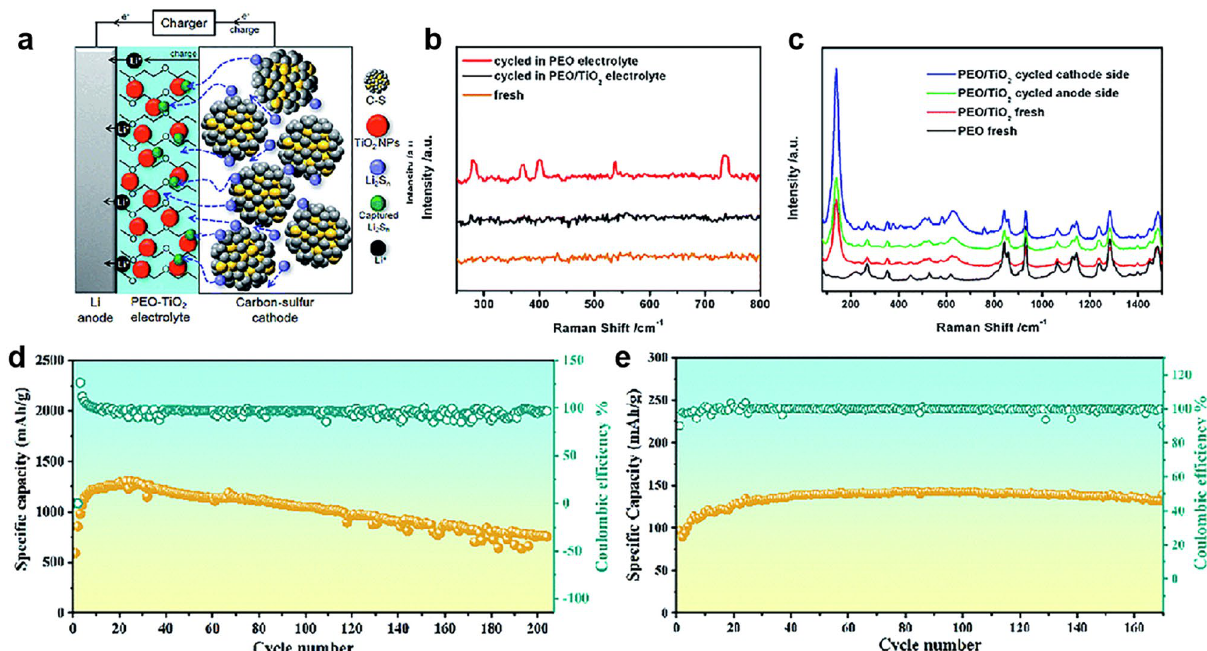
Fig. 14 a Schematic illustration of the inhibition of soluble Li 2 S n diffusion. Upon charging, Raman spectra of b Li anode and PEO and c PEO/ TiO 2 electrolytes before and after cycling. a – c Reproduced with permission [201]. Copyright 2017, Royal Society of Chemistry. d Discharge capacity and Coulombic efficiency of the Li–S battery based on MB-LLZTO CSE at 45 °C. e Discharge capacity and Coulombic efficiency of the MB–LLZTO CSE-based LFP–Li battery at 45 °C. d , e Reproduced with permission [98]. Copyright 2019, Royal Society of Chemistry